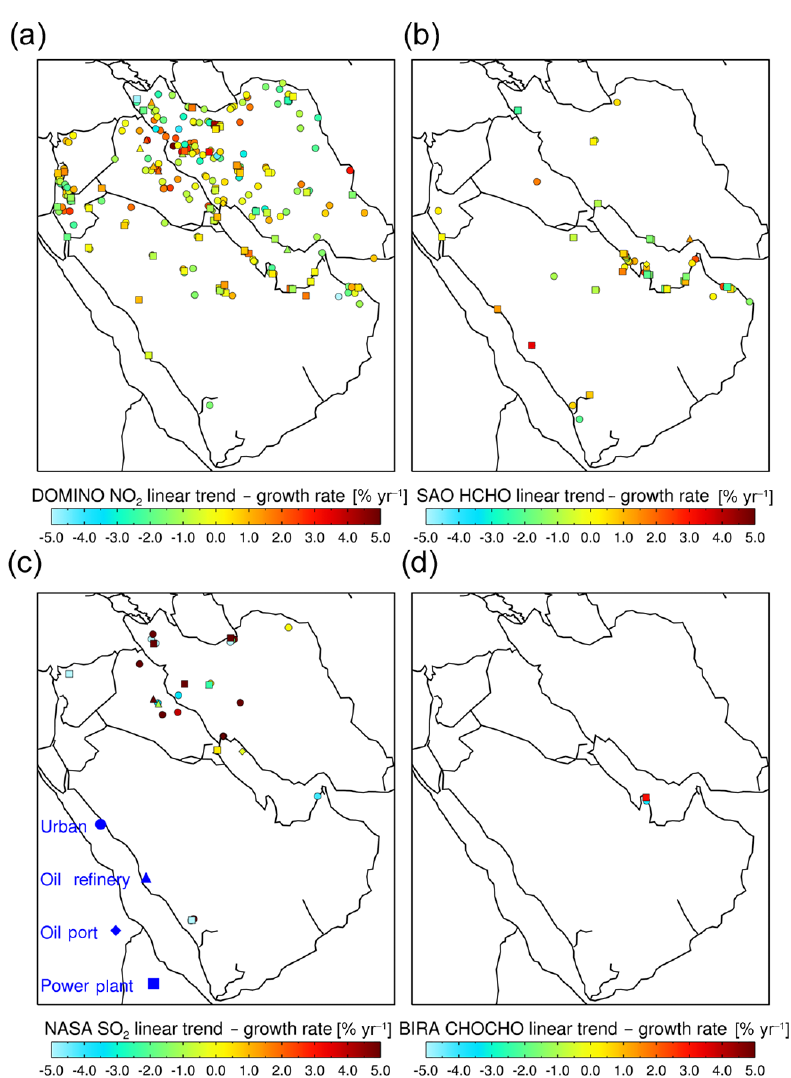
Figure 6. Geographical distribution of locations with statistically significant linear trends in NO 2 (a) , HCHO (b) , SO 2 (c) , and CHOCHO (d) , but here showing the linear trend (in percent per year) minus the growth rate (in percent per